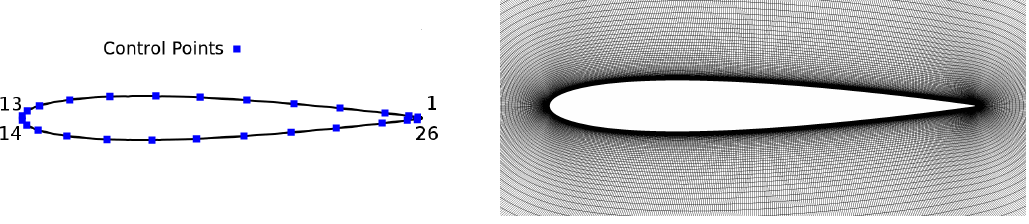
Figure 3. Control points of the verification case and close-up view of the mesh near the